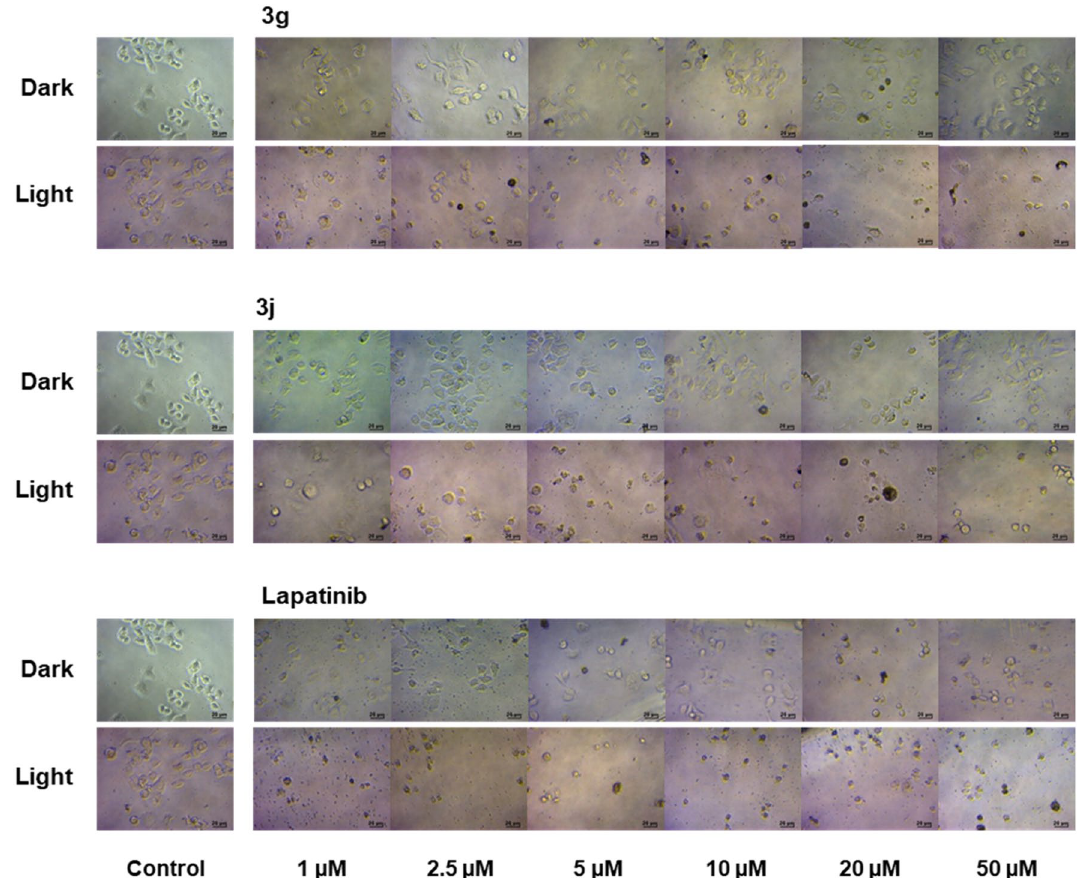
Figure 5. The morphology of SK-BR-3 cells treated with different concentrations of compounds 3g , 3j , and lapatinib at 48 h under dark and light activation (irradiation with UVA 2.0 J/cm 2 ). Cells treated with 1% DMSO served as